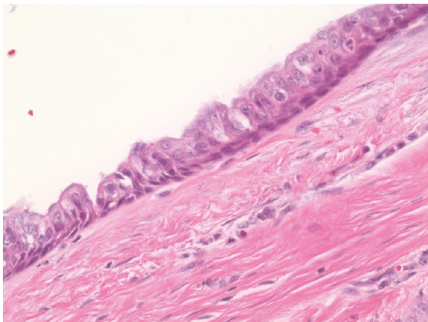
Figure 4: The cystic structure is lined by respiratory-type epithe- lium, consistent with thyroglossal duct cyst (H&E stain, 400x original